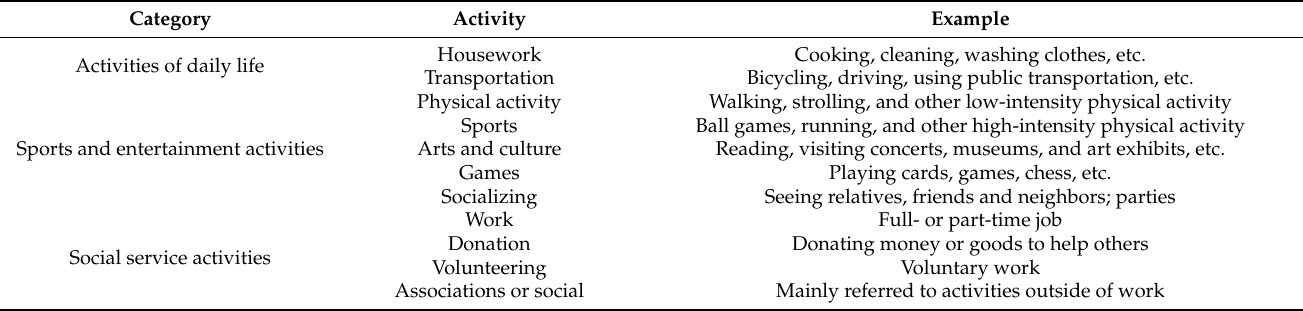
Table 1. Information on social